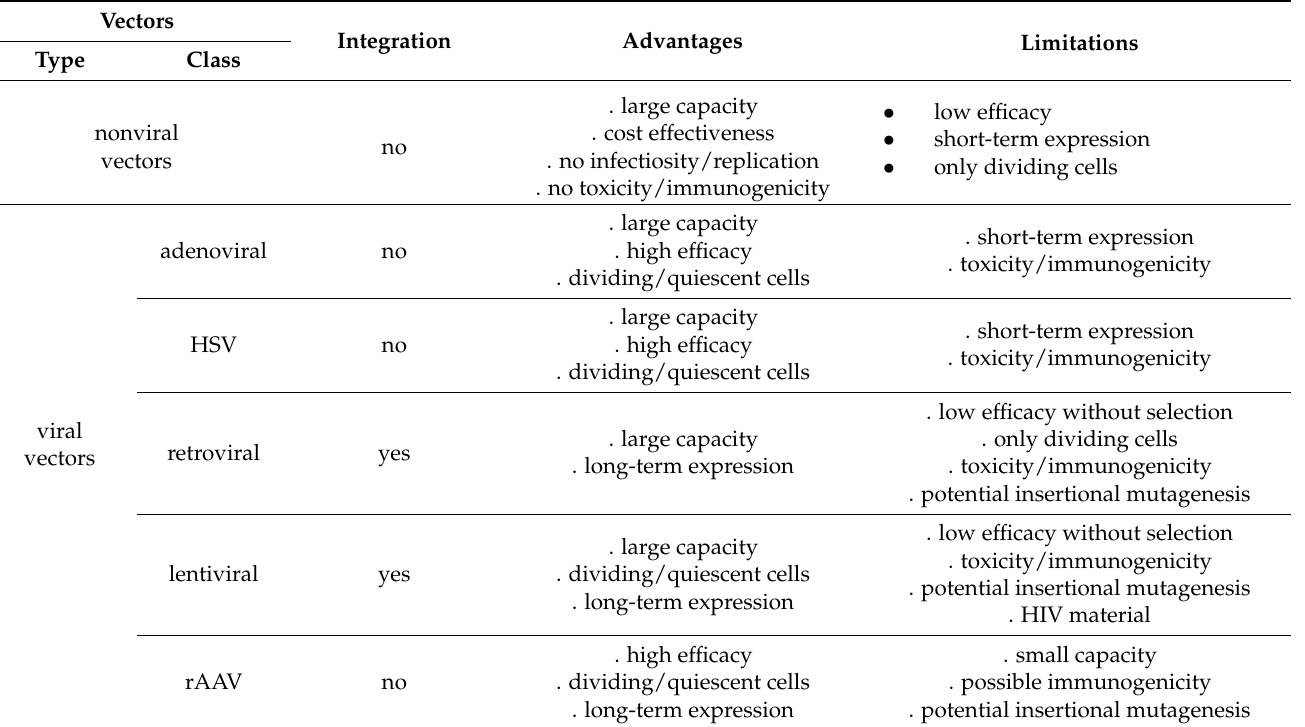
Table 2. Gene transfer